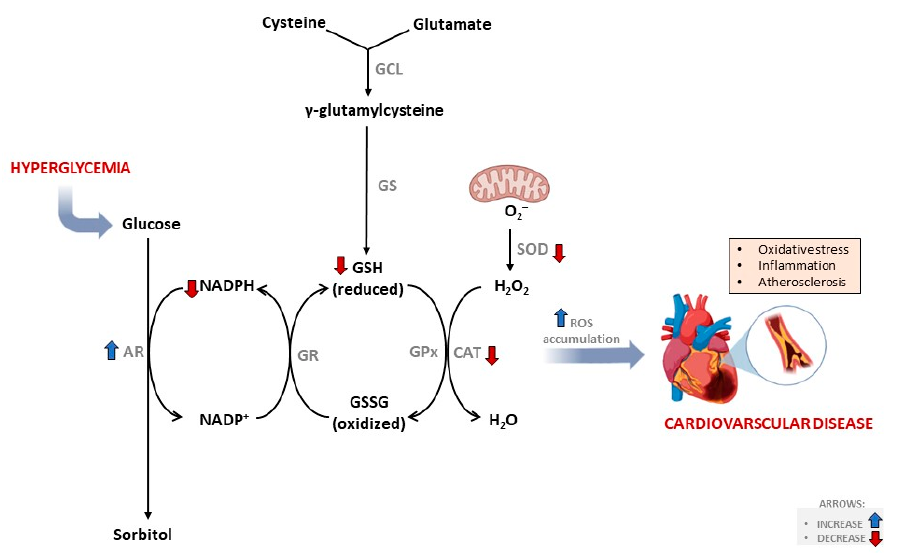
Figure 1. An overview of the glutathione biosynthesis pathway and its influence from external factors like free radical species. Briefly, the diabetic state is associated with depleted intracellular antioxidants (including glutathione) and increased risk of developing of atherosclerosis and cardiovas- cular disease. Both oxidative stress and inflammation are implicated in this process. Abbreviations; AR: aldose reductase, CAT: catalase, GCL: γ -glutamyl cysteine synthetase, GS: glutathione synthe- tase, GSH: glutathione, GR: glutathione reductase, GPx: glutathione peroxide, GSH: glutathione, GSSG: glutathione disulfide, NADPH: nicotinamide adenine dinucleotide phosphate, SOD, super- oxide dismutase, ROS: reactive oxygen species.